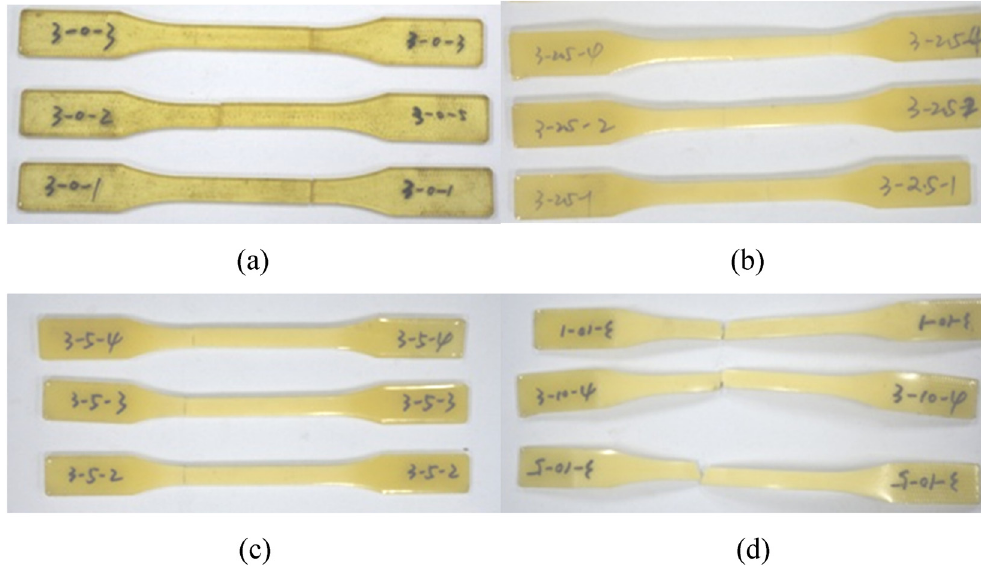
Figure 1: Failure modes of the specimens with di ff erent starch content: ( a ) 0 wt%, ( b ) 2.5 wt%, ( c ) 5 wt%, and ( d ) 10